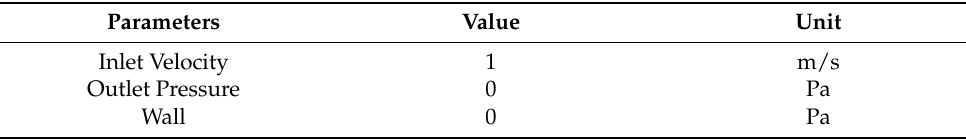
Table 4. Boundary conditions for the k-epsilon CFD 2D model.